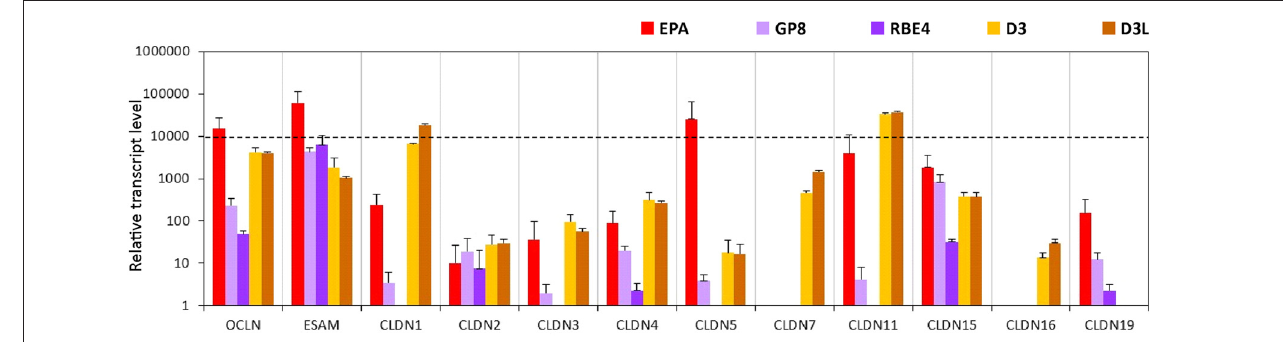
FIGURE 6 | Relative transcript levels of selected genes encoding SLC and other nutrient transporters measured by inventoried TaqMan Gene Expression Assays in a primary rat brain endothelial cell-based BBB model (EPA) and in brain endothelial cell line models (GP8, RBE4, D3 and D3L).